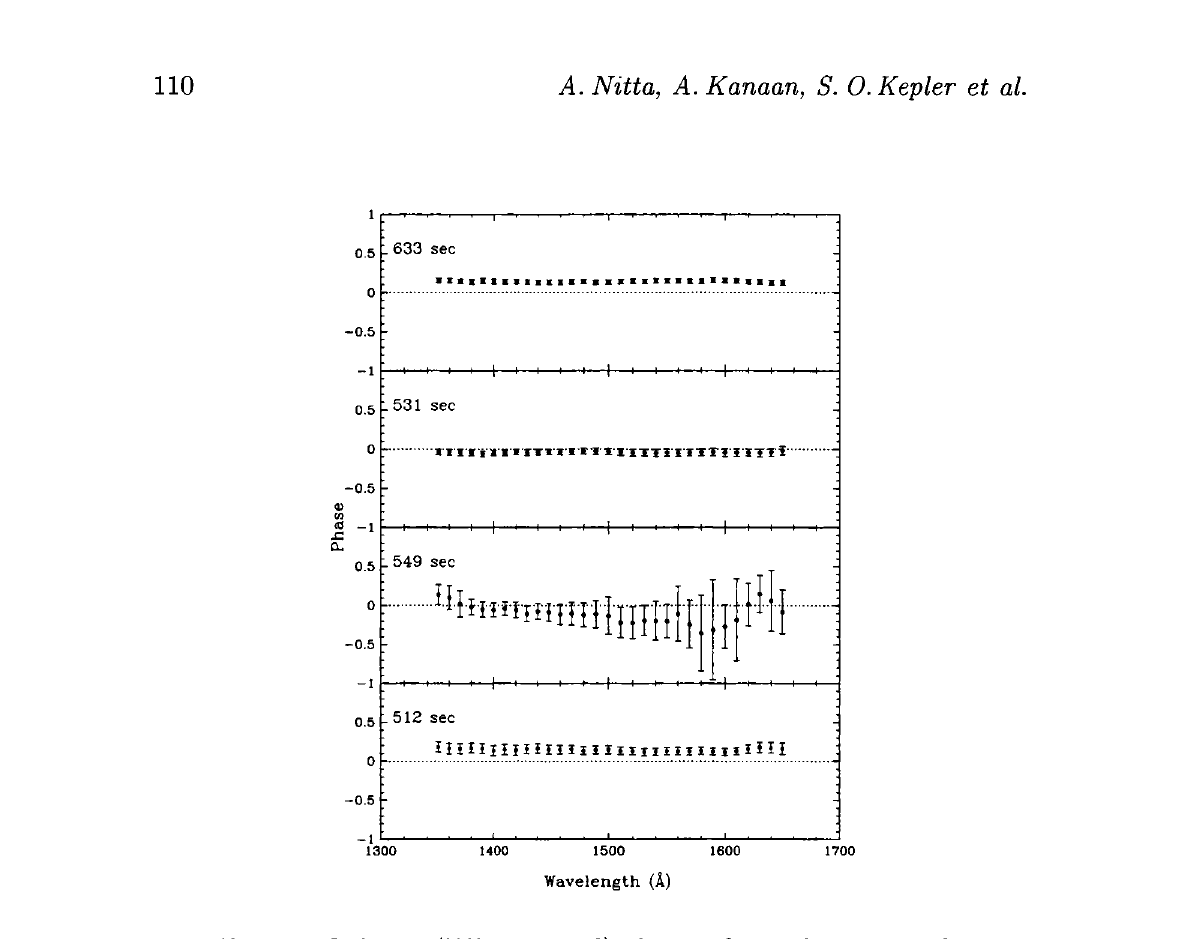
Fig. 10. Relative (UV to optical) phases of 4 modes vs. wavelength. When the phase is equal to zero, the UV is in phase with the optical data. When it is ±0.5, it means that the UV phase is out of phase (±7r) with the optical. The phases of 633 s, 531s, 549 s modes appear in phase in phase within the UV, but have offset from the optical